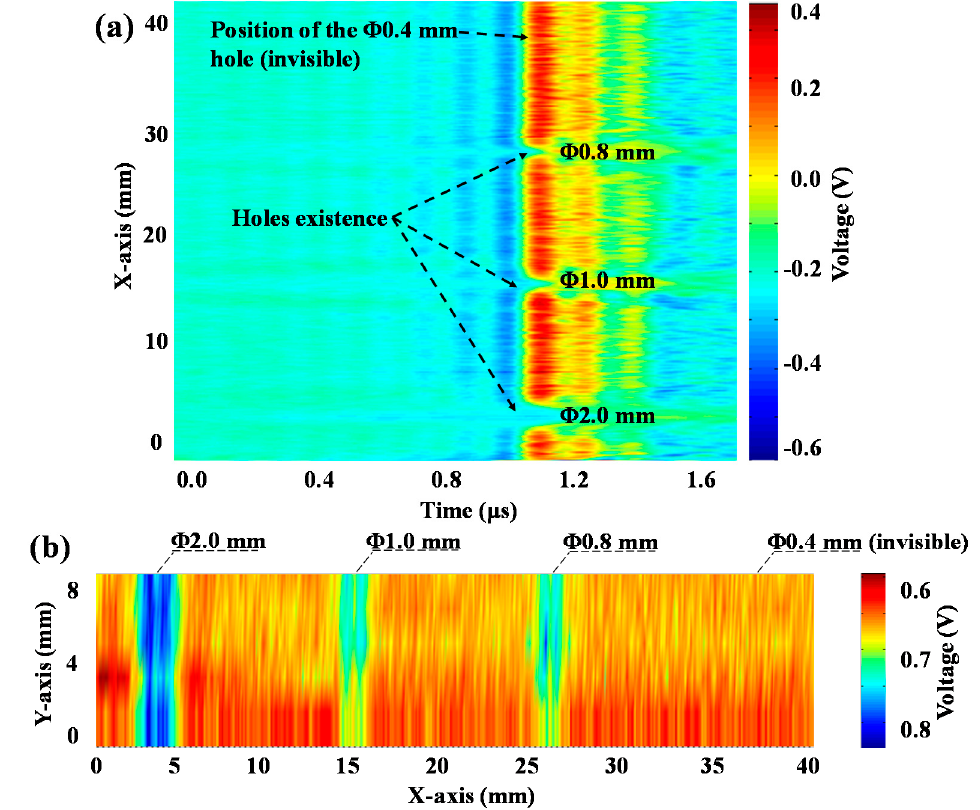
Figure 6. LUT results of the sample: ( a ) B-Scan image indicating the presence of hole-type defects of the plane ( Y = 5 mm, in the X–Z plane in Figure 3) and ( b ) C-Scan image demonstrating internal hole-type defects (parallel to the X–Z plane in Figure 3).